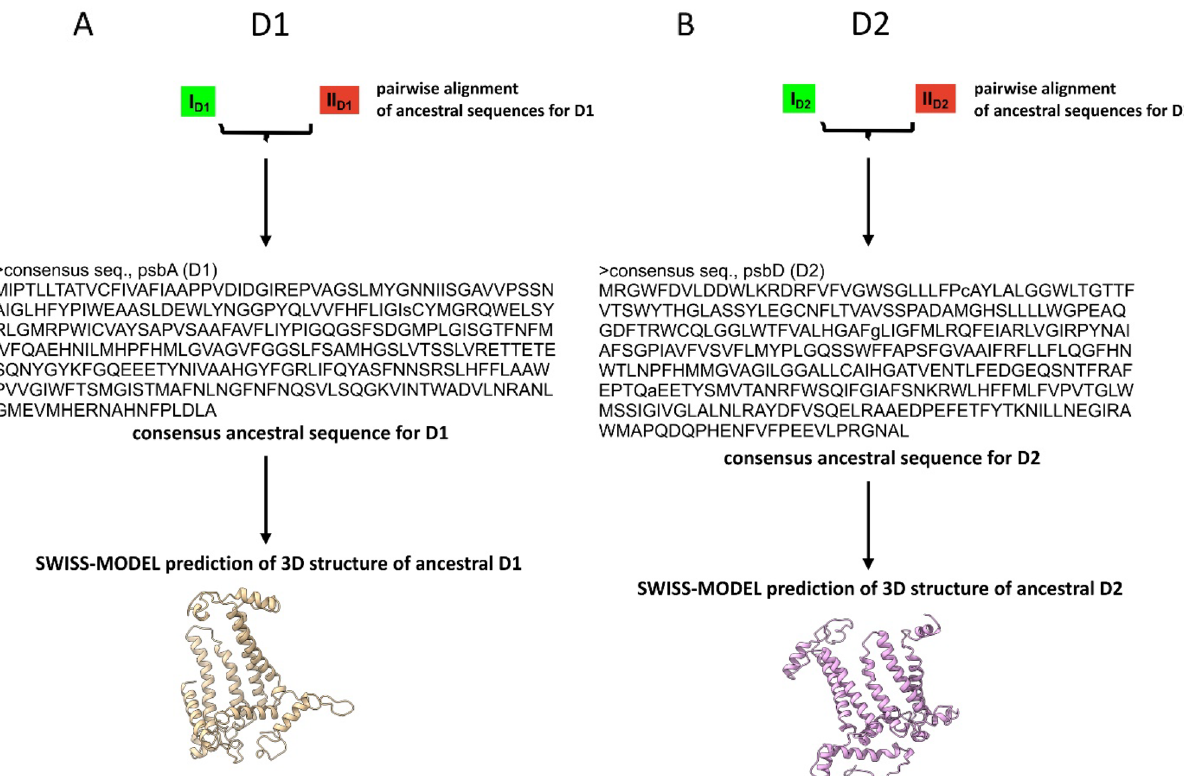
Figure 5. The scheme of ancestral sequence reconstruction for D1 and D2 proteins. ( A ) The consensus sequence for D1, obtained from the alignment of the ancestral sequences: I D1 and II D1 from the tree in Fig. 1A (Supplementary Information Notes S3), was used to reconstruct the spatial structure of the protein. ( B ) The consensus sequence for D2, obtained from the alignment of the ancestral sequences: I D2 and II D2 from the tree in Fig. 1B (Supplementary Information Notes S4), was used to reconstruct the spatial structure of the protein (see “Methods” for